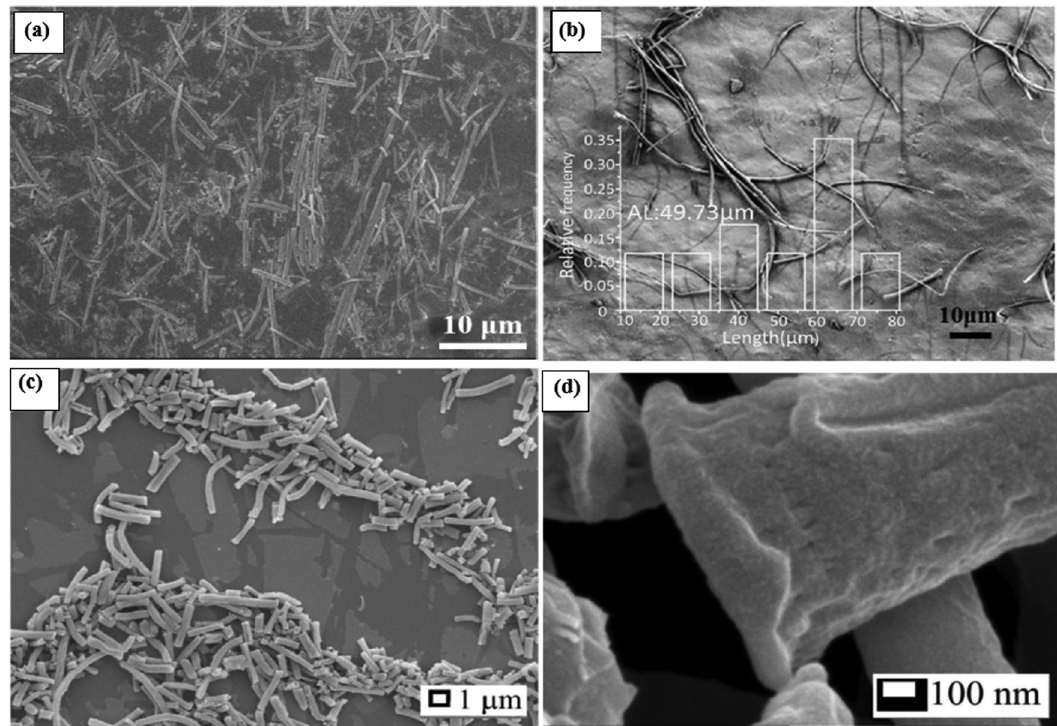
Figure 1: Short nano fi ber of ( a ) brittle PAN with average length range of 3 – 7 µm [ 52 ] ; Copyright 2013, reproduced with permission from Elsevier Ltd, ( b ) composite nano fi bers ( GO/Iron oxide - reinforced PAN ) with average length of 49.73 µm [ 59 ] ; Copyright 2013, reproduced with permission from Elsevier Ltd, ( c ) ductile irradiated poly ( lactic acid ) ( PLLA ) with average length of 5 µm [ 24 ] , and ( d ) pitting of PLLA nano fi ber [ 24 ] ; Copyright 2013, reproduced with permission from Elsevier